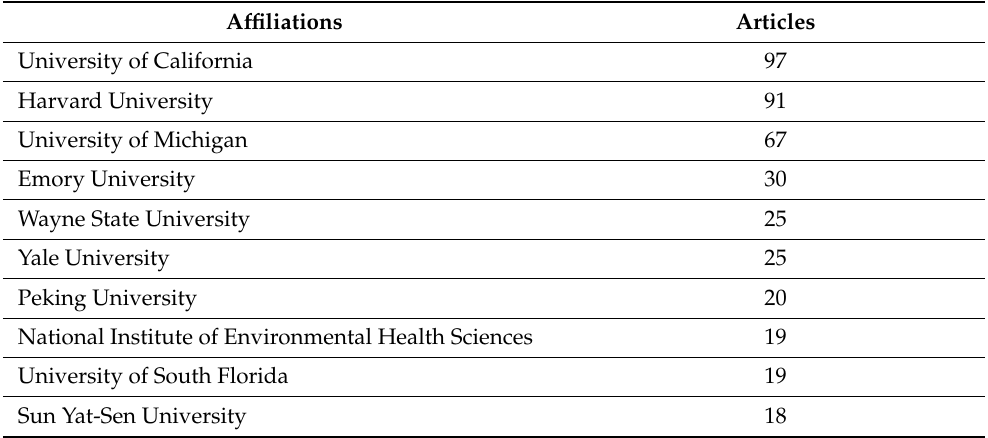
Table 4. Top institutions that published regarding environmental toxicants and pollutants and preterm birth.